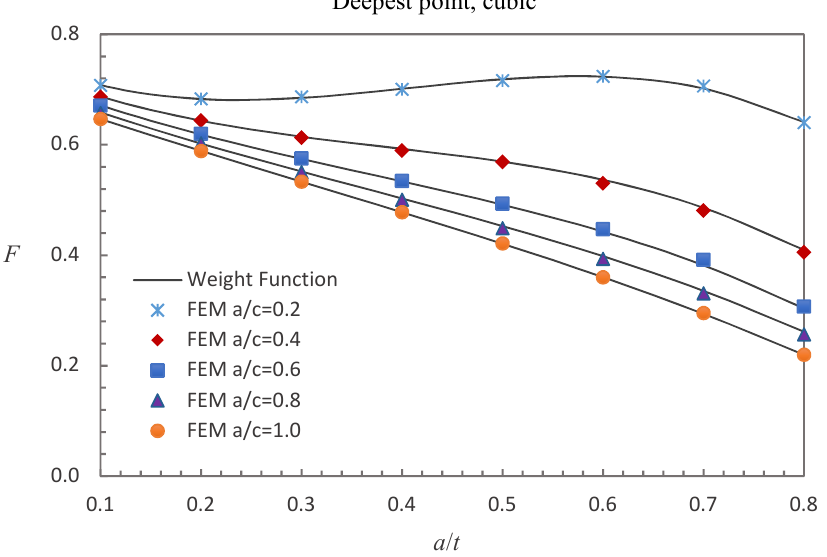
Figure 9. Comparison of weight function and FE results in this study with cubic stress distribution (deepest point).